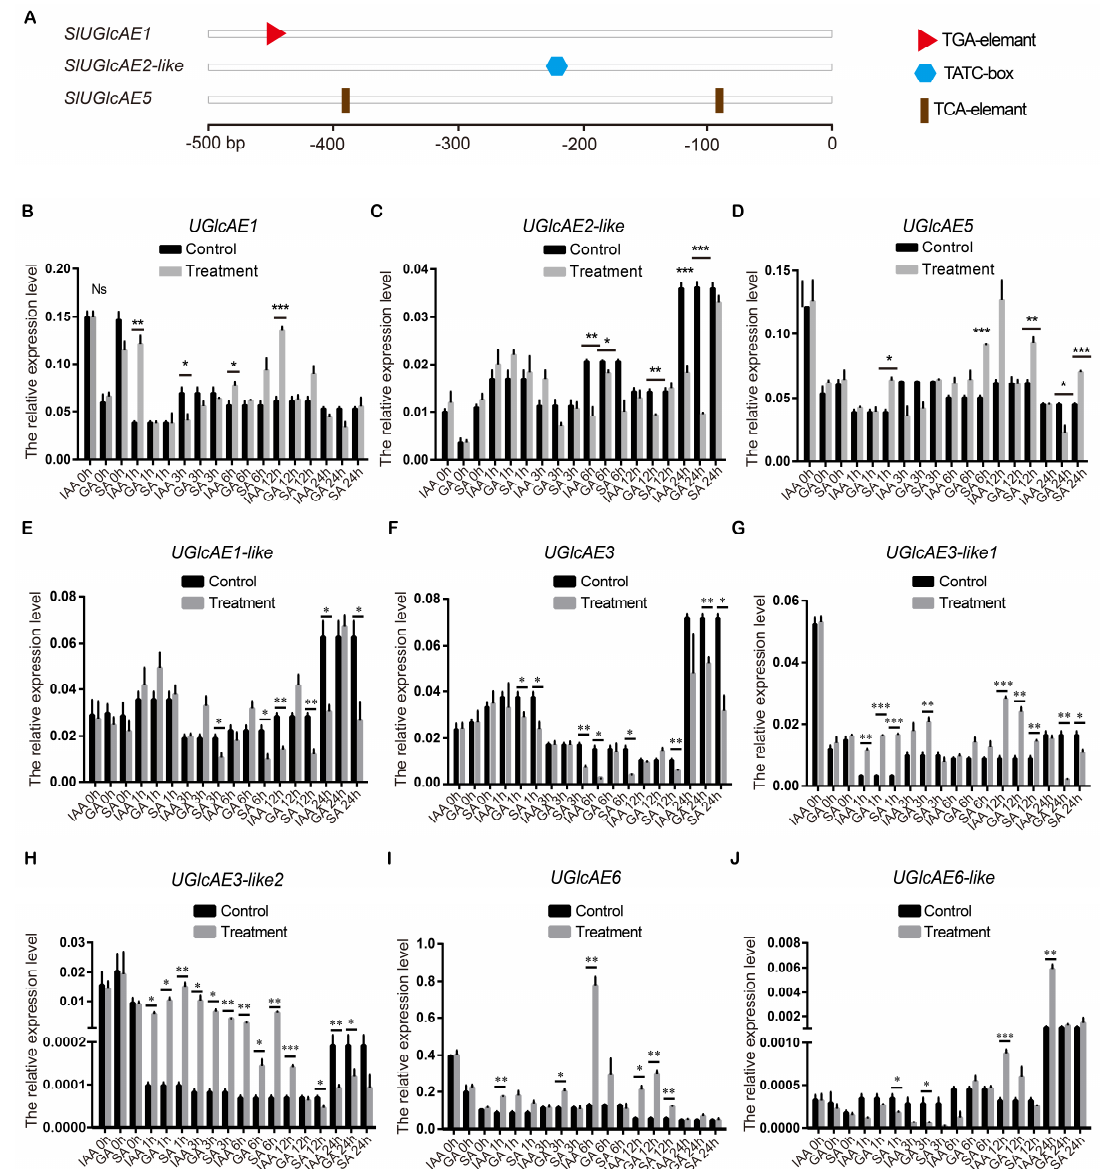
Figure 9. The detection of expressional level of SlUGlcAE genes after plant hormone treatments. ( A ) Hormone‐related cis ‐elements prediction in the upstream of three SlUGlcAE genes (TGA‐element: auxin‐responsive element, TATC‐box: gibberellin‐responsive element, TCA‐element: salicylic acid‐responsive element); ( B ) The qPCR expression analysis of SlUGlcAE1 response to plant hormone treatments; ( C ) Responses of SlUGlcAE2-like to plant hormones; ( D ) Expression profile analysis of SlUGlcAE5 under plant hormone treatments; ( E ) Expression of SlUGlcAE1-like after hormone treatments; ( F ) Expression level of SlUGlcAE3 after three hormones treatments; (G) Responses of SlUGlcAE3-like1 under hormone treatments; ( H ) Expression profile analysis of SlUGlcAE3-like2 to plant hormones; ( I ) The expression analysis of SlUGlcAE6 under three hormones treatments; and, ( J ) Expression pattern of SlUGlcAE6-like response to plant hormone treatments. The error bars represent the SEM. * p < 0.05, ** p < 0.01, *** p < 0.001, Ns: No significant.